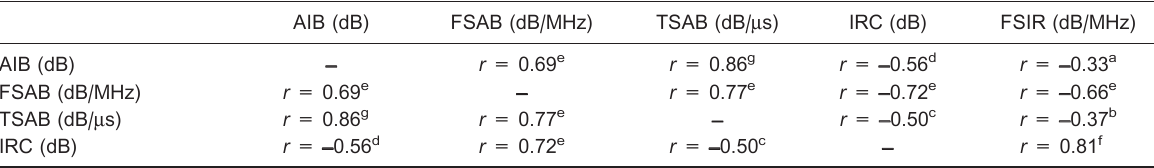
Table 3. Pearson’s correlation coefficient ( r ) of parameters and P for Experiment 2.